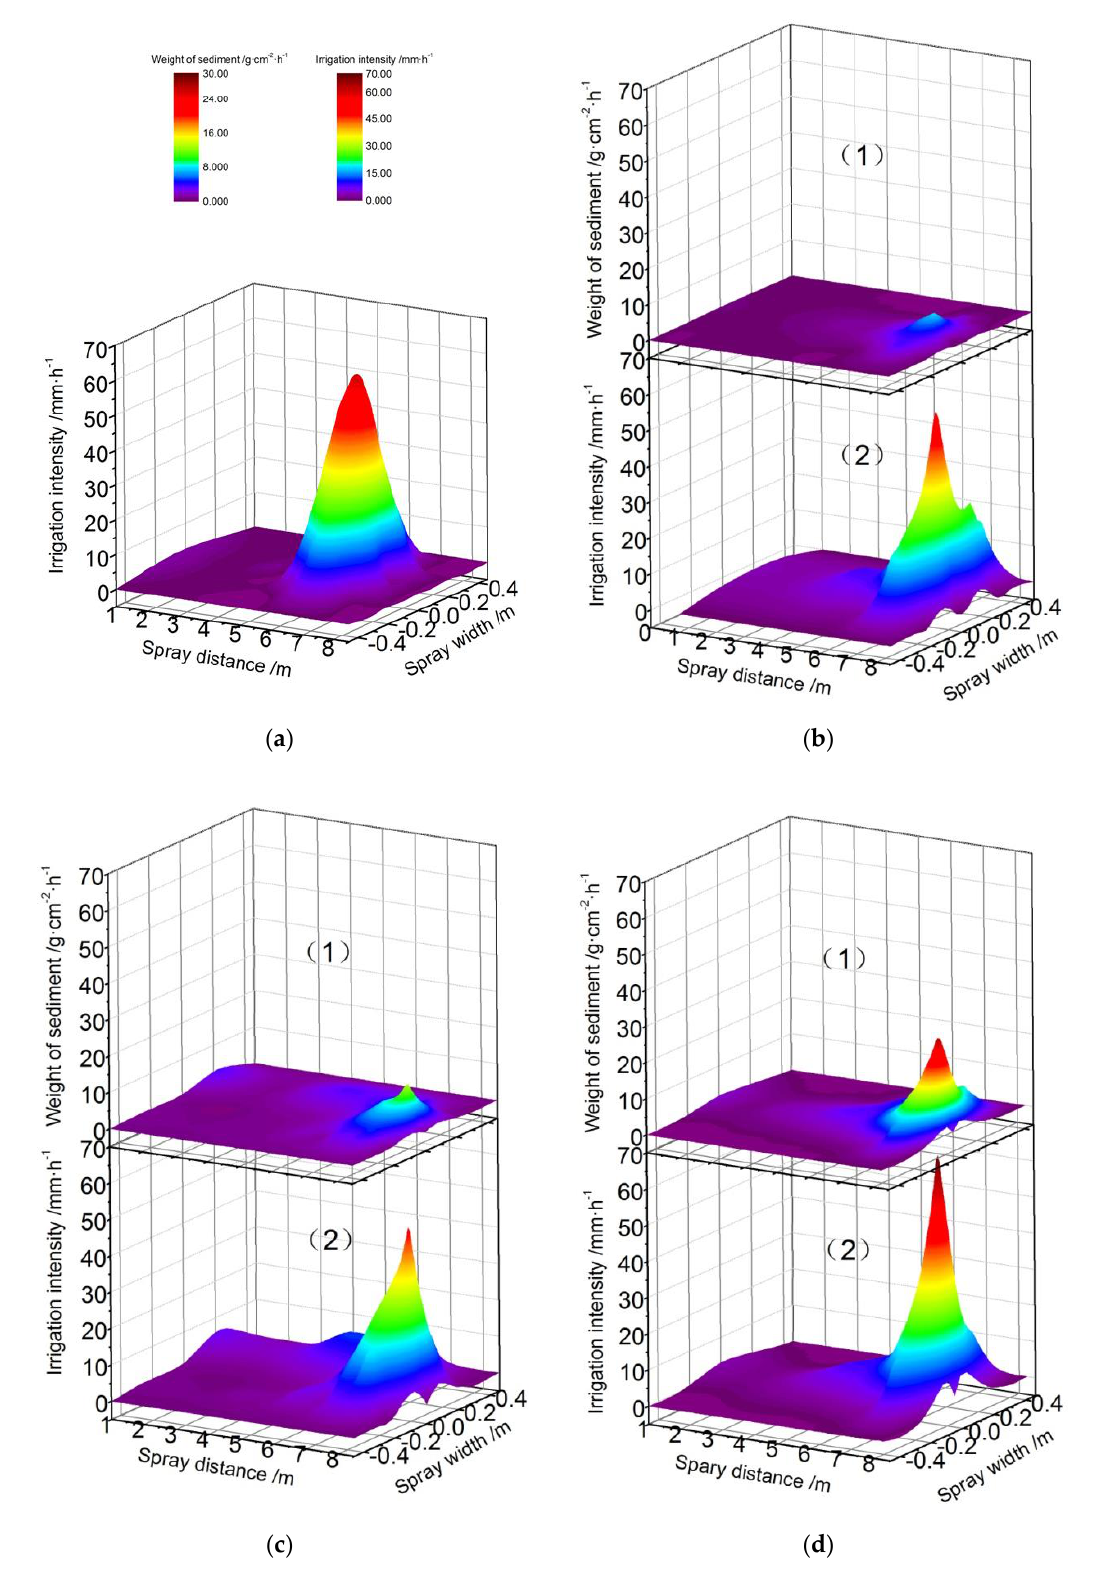
Figure 3. Water and sediment distribution patterns of one groove with 2 m mounting height at 150 Figure 3. Waterandsedimentdistributionpatternsofonegroovewith2mmountingheightat150kPa. Note: kPa. Note: ( a ) clean water; ( b )1% sediment concentration; ( c ) 3% sediment concentration; ( d ) 5% ( a )cleanwater; ( b )1%sedimentconcentration; ( c )3%sedimentconcentration; ( d sediment concentration.